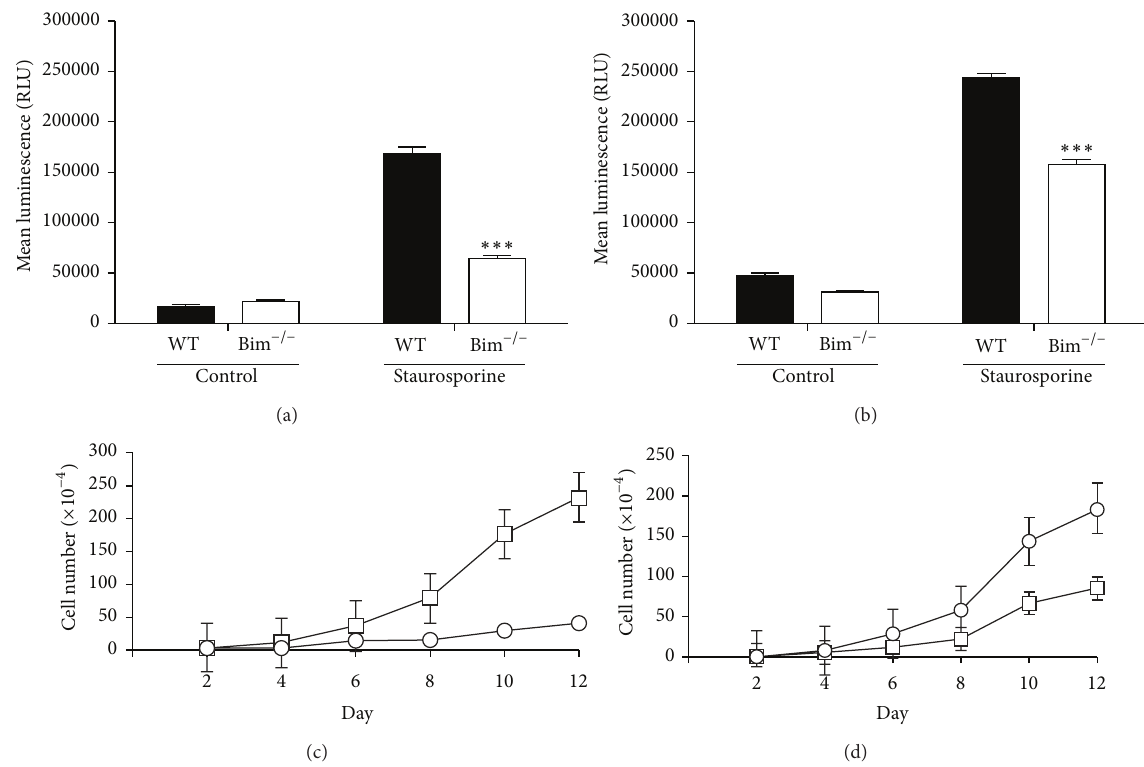
Figure 2: Modulation of proliferation in Bim −/− cells. Wild-type and Bim −/− retinal endothelial cells (panel (a)) and pericytes (panel (b)) were incubated with 10nM staurosporine for 24 hours. Apoptosis was determined using a Caspase-Glo 3/7 assay. Wild-type and Bim −/− retinal endothelial cells (panel (c)) and pericytes (panel (d)) were monitored for their growth rate over a two-week time frame for wild-type ( I ) and Bim −/− ( ◻ ) cells. These experiments were repeated twice with similar results ( ∗∗∗ 𝑃 < 0.001